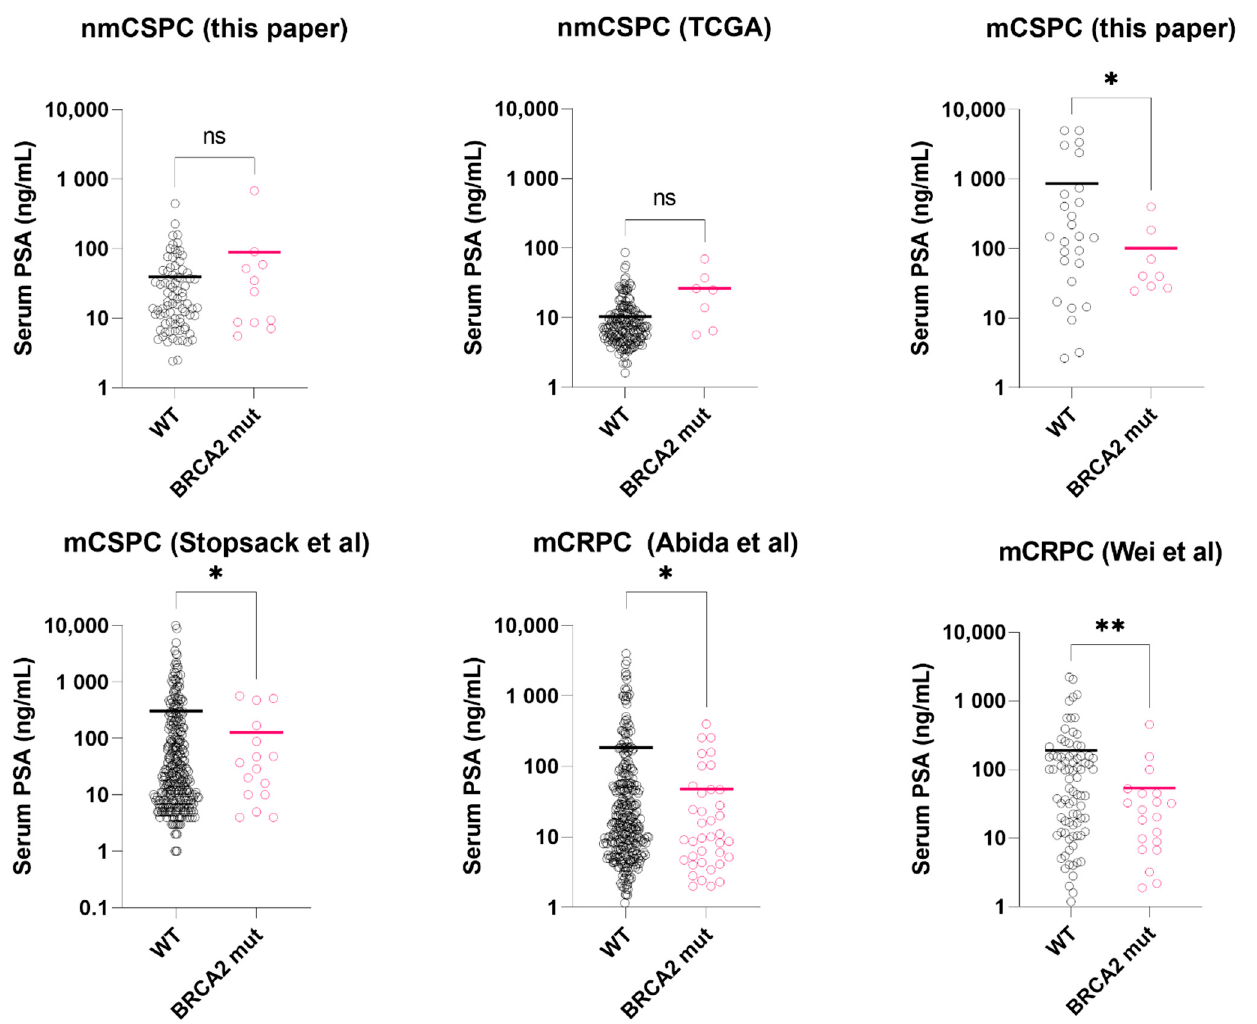
Figure 1. Serum PSA level at diagnosis in BRCA2 -mutated vs. wild-type prostate cancer, stratified by metastatic stage and castration-sensitivity. Asterisks: * p < 0.05; ** p < 0.01. black circle: BRCA2 wild-type sample (WT); pink circle:BRCA2 mutated sample (mut). Colored bar =median. Datasets: This paper, TCGA. [24], Stopsack et al. [23], Abida et al. [22], Wei et al. [6].